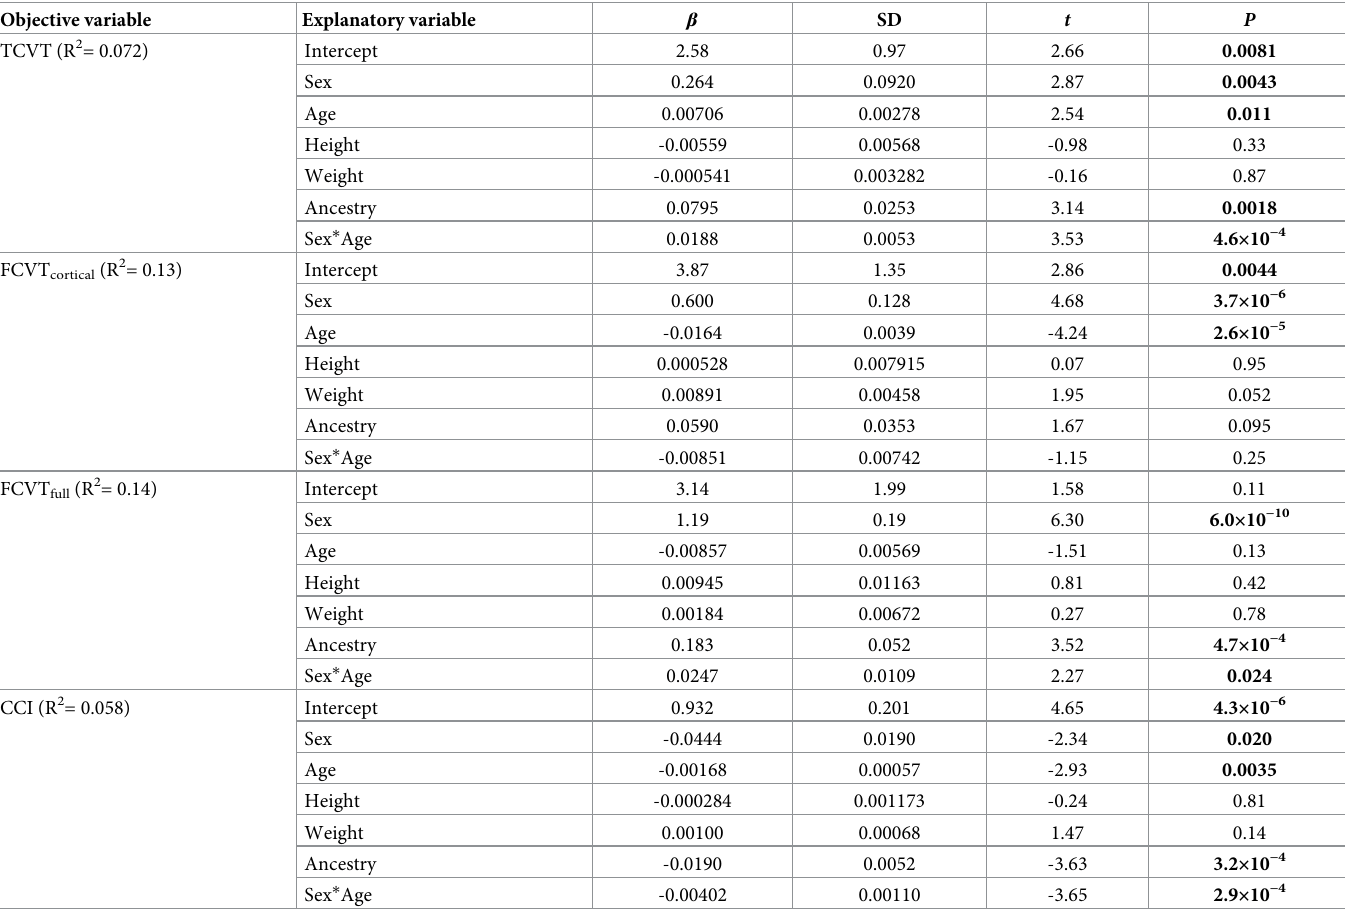
Table 2. Multiple regression analysis of